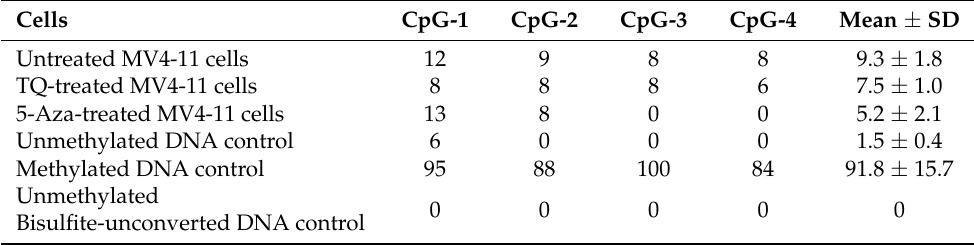
Table 1. Percentage of methylation of CpG sites in the promoter region of SHP-1 gene.